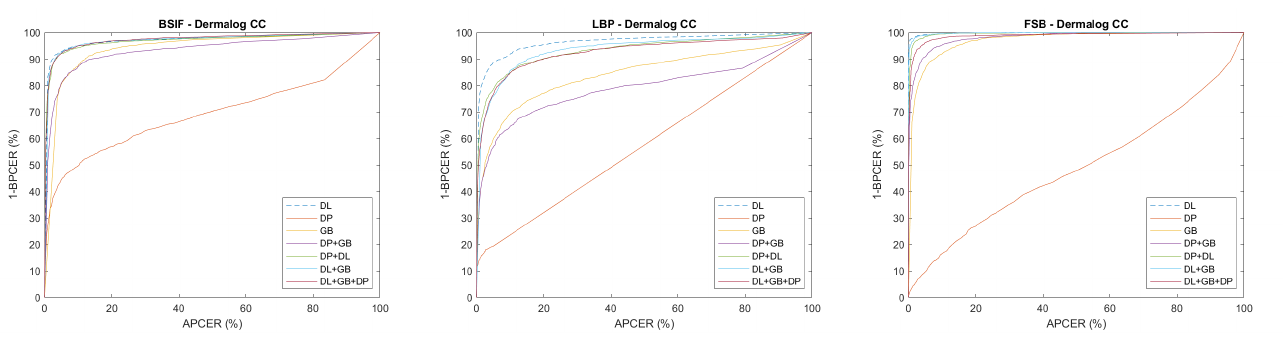
Figure 5. Comparison between ROCs of our self-trained PAD systems in an intra- (dashed) and cross- (solid) sensor scenario on the Orcanthus dataset from LivDet 2019.